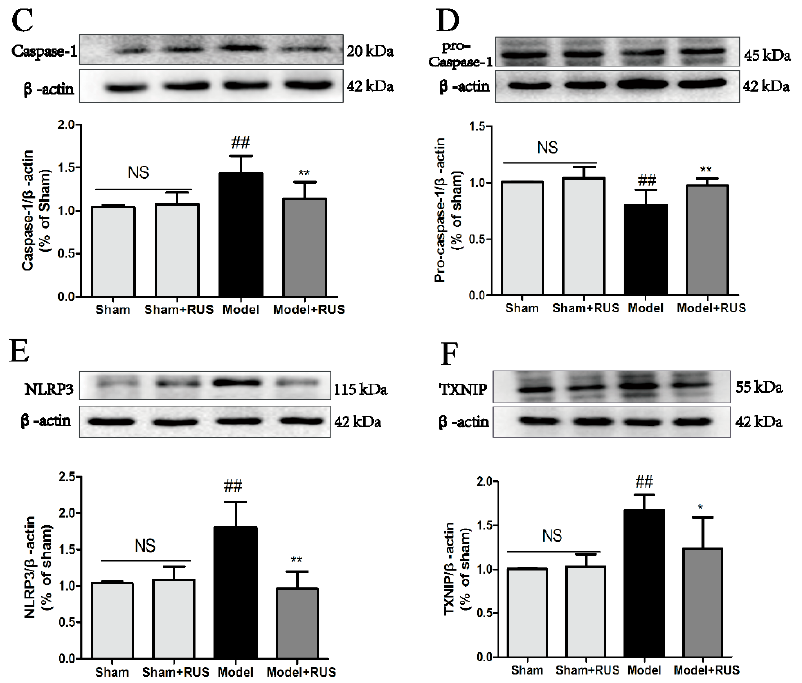
Figure 4. Effects of ruscogenin on the TXNIP/NLRP3 pathway in mice following MCAO/R. ( A – F ) Representative Western blot bands and quantitative analysis of the ratio of IL-1 β and pro-IL-1 β , caspase-1 and pro-caspase-1, NLRP3 and TXNIP. The band intensities were measured using scanning densitometry. The data were normalized to β -actin expression ( n = 3). NS means “not significant”. The data are expressed as means ± SD. ## p < 0.01 ν s. Sham, * p < 0.05, ** p < 0.01 ν s. Model.